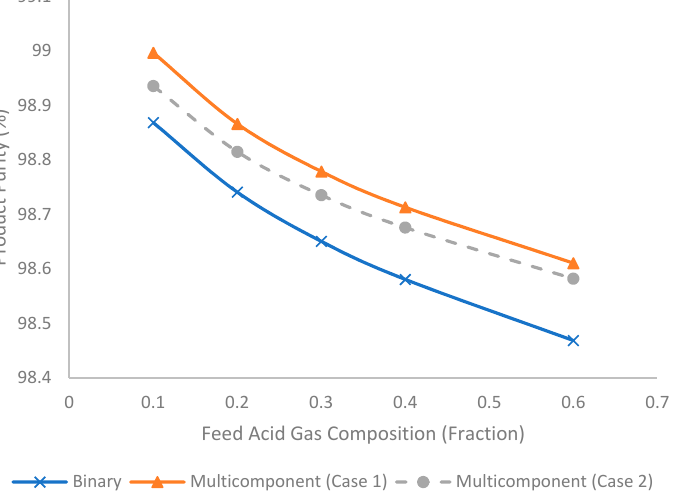
Figure 15. Evolution of product purity (%) under different acid gas composition for binary and multicomponent systems.